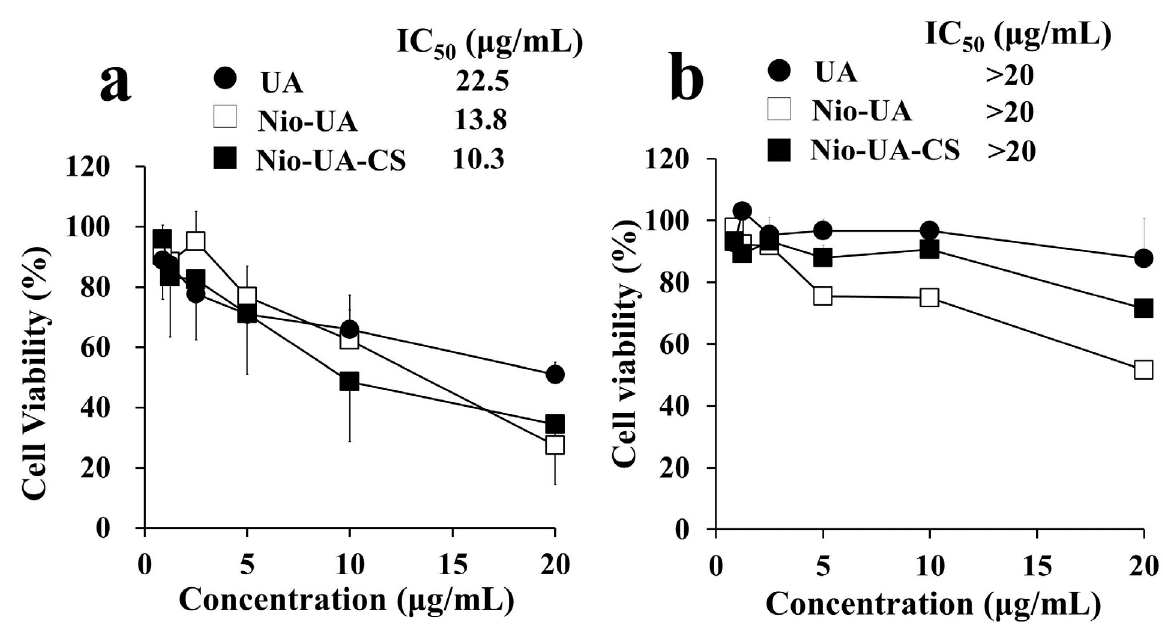
Figure 1. Viability of HeLa (a) and Huh7it (b) cells in the presence of UA, Nio-UA and Nio UA-CS treatment after incubation for 48 hours at various